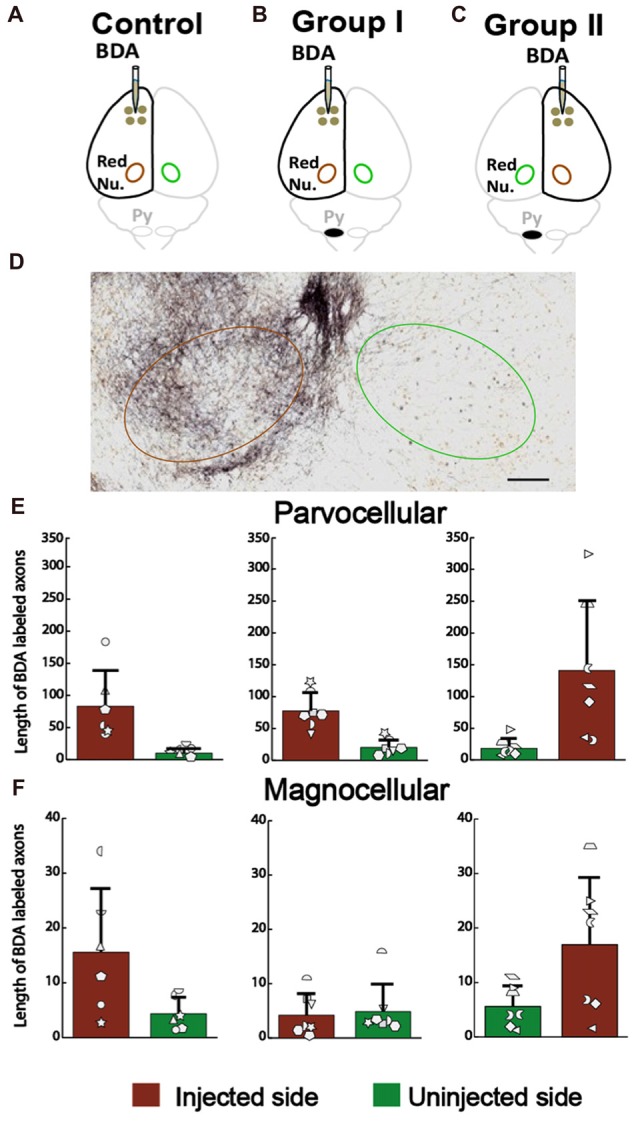
No increase in the corticorubral axons from the injured hemisphere after neonatal pyramidotomy. (A–C) Experimental schema of injections of BDA, pyramid (Py) cut, and the analyzed sides of the red nucleus (Red Nu.) in the Control (A), Group I (B) and Group II (C). (D) The BDA-labeled axons in the red nucleus. Brown circle shows the BDA injected side; the green one the uninjected side. Bar = 125 μm. (E) Average BDA-labeled axon length in parvocellular red nucleus. There were no differences in the injected or in the uninjected side of the red nucleus among three groups. (F) Average BDA-labeled axon length in magnocellular red nucleus. There were no differences in the injected or in the uninjected side of the red nucleus among three groups. (E,F) Plotted white shapes correspond to each rat’s data points. Each rat’s data in the Control group, Group I and Group II were represented by a particular shape.